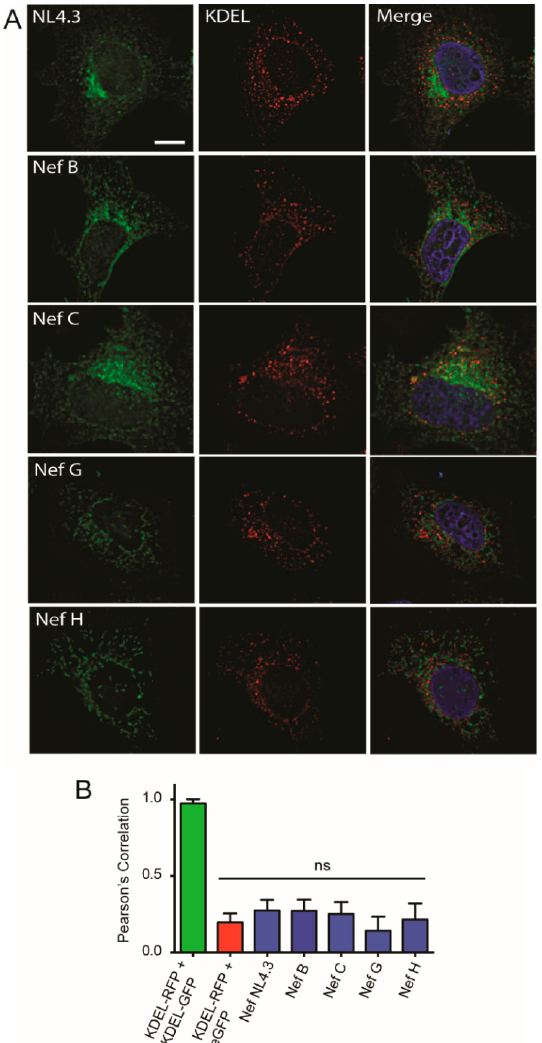
Figure 5. Nef proteins from reference strains of HIV-1 group-M subtypes do not localize to the endoplasmic reticulum. ( A ) CD4 HeLa cells were transfected with various Nef–eGFP fusion plasmids encoding Nef from different HIV-1 subtype reference strains or a vector encoding KDEL–red fluorescent protein (RFP). Cells were fixed in 4% paraformaldehyde, and imaged on a Leica DMI6000 widefield microscope on the 100 × objective; scale bar = 10 µ m, green = Nef–eGFP, red = KDEL–RFP. ( B ) Images were deconvolved, and colocalization analysis was completed using the Pearson’s Correlation with the Image J JaCoP plugin. Green bar = positive control, red bar = negative control. Mean (+/ − SD) Pearson’s correlations of Nef and KDEL–RFP colocalization are illustrated from three independent experiments. (ns: non-significant; SD: standard